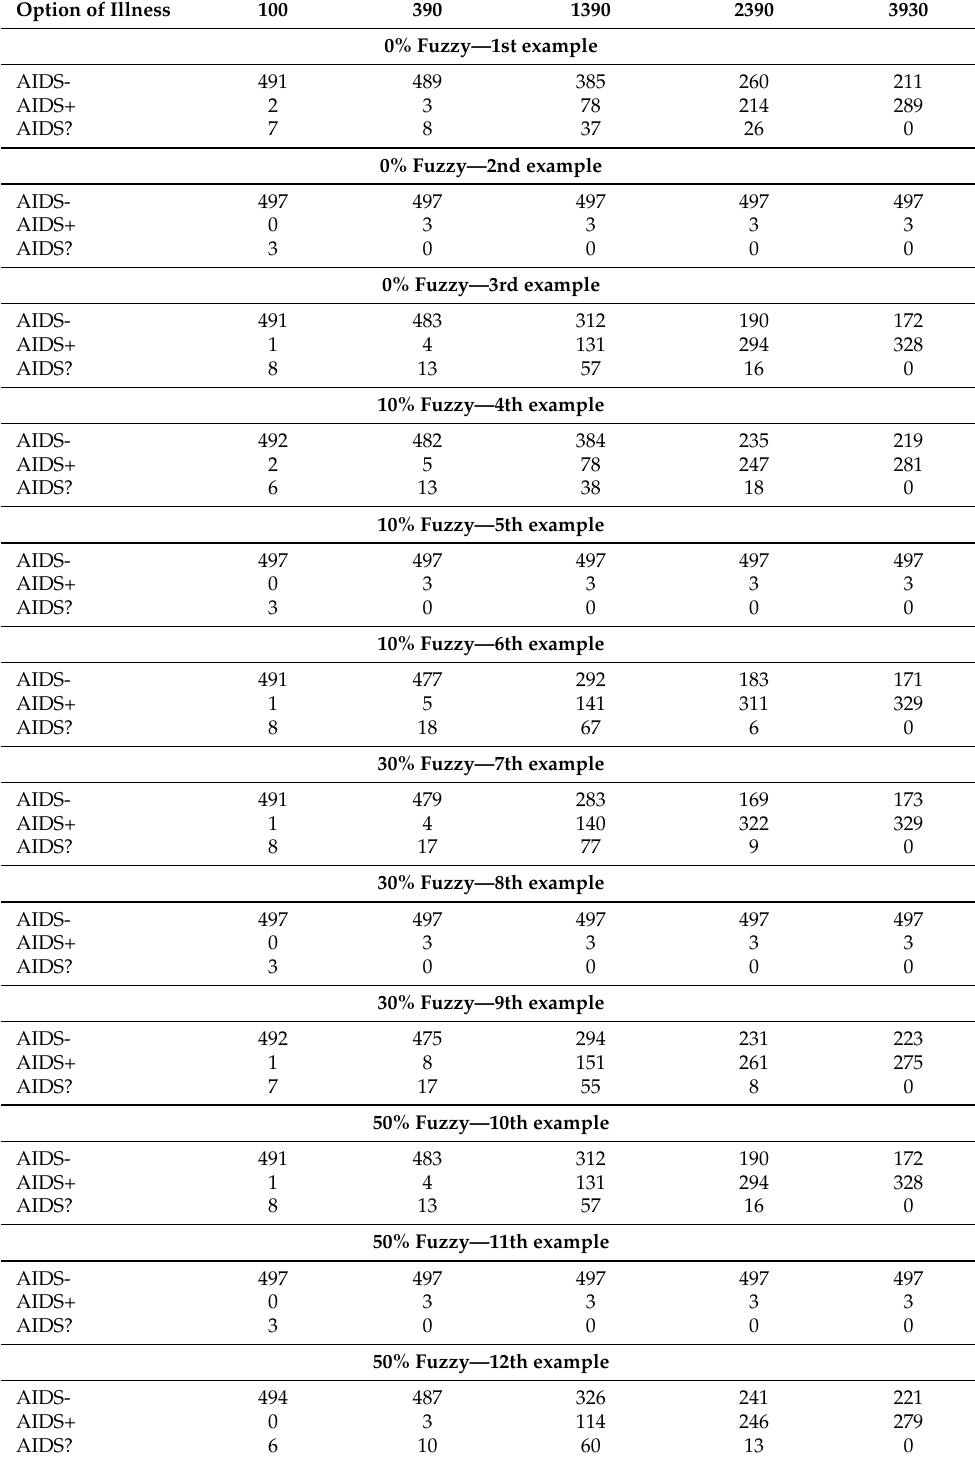
Table 6. People regarding the third scenario for a different number of